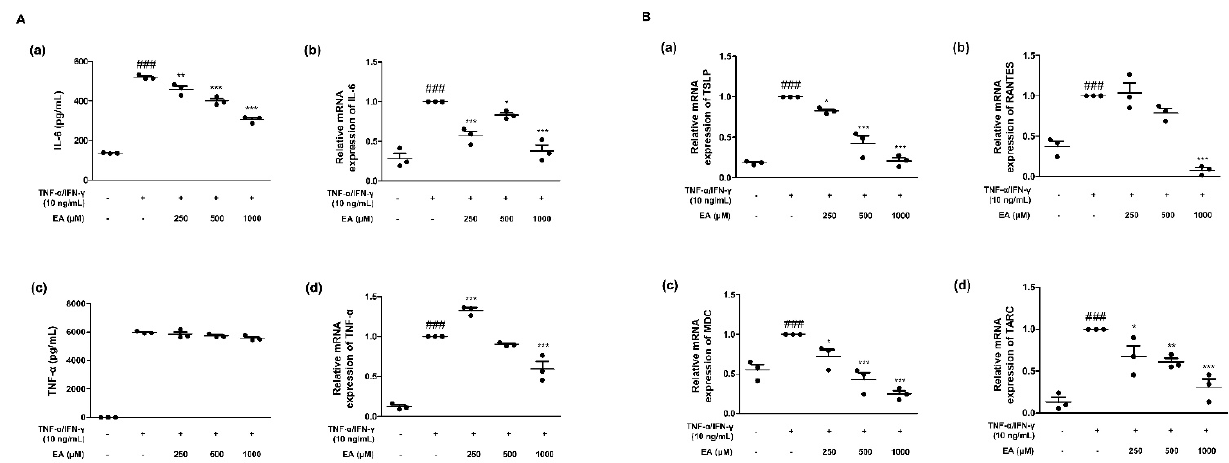
Figure 1. Effects of ellagic acid (EA) on inflammatory cytokines and chemokines in HaCaT keratinocytes. ( A ) Production of inflammatory cytokines and their mRNA expression were determined. Production of ( a ) interleukin-6 (IL-6) and ( c ) tumour necrosis factor- α (TNF- α ) was determined by enzyme-linked immunosorbent assay (ELISA). Cells were treated with 250, 500, or 1000 µ M of EA for 1 h prior to the addition of TNF- α /IFN- γ , and cells were incubated for 24 h. mRNA expression of ( b ) IL-6 and ( d ) TNF- α was assayed by qRT-PCR. ( B ) mRNA expression of pro-inflammatory chemokines. mRNA expression of ( a ) thymic stromal lymphopoietin (TSLP), ( b ) normal T-cell expressed and secreted chemokine (RANTES), ( c ) macrophage-derived chemokine (MDC), and ( d ) thymus and activation-regulated chemokine (TARC) was assayed by qRT-PCR. Cells were treated with 250, 500, or 1000 µ M of EA for 1 h prior to the addition of TNF- α /IFN- γ , and cells were incubated for 6 h. Then, total RNA was isolated from HaCaT keratinocytes, and qRT-PCR was performed. Data are presented as the mean ± standard error mean (SEM) of three independent experiments ( n = 3); * p < 0.05, ** p < 0.01 and *** p < 0.001 versus the only TNF- α /IFN- γ -treated group, ### p < 0.001 versus the control group by ANOVA and Dunnett’s post-hoc test.